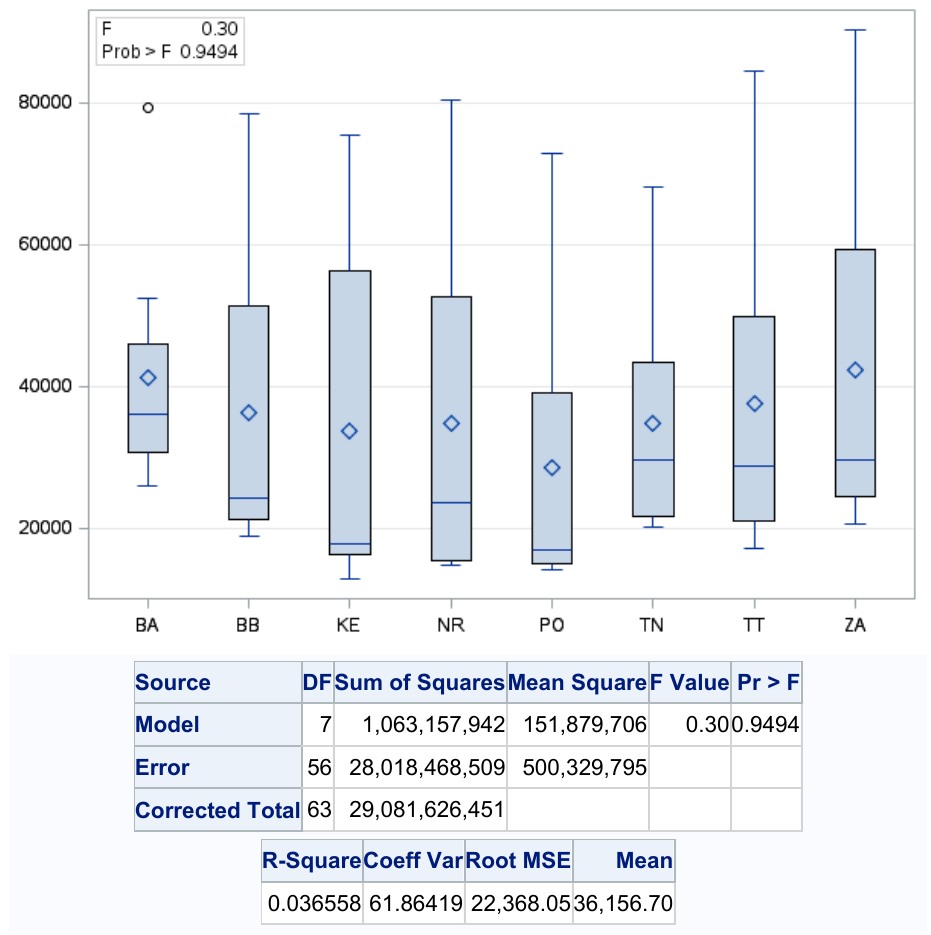
Figure 5. One-factor analysis of municipal waste separation in the regions of Slovakia. Source: Based on of data collected by Statistical Office of Slovak Republic [29].